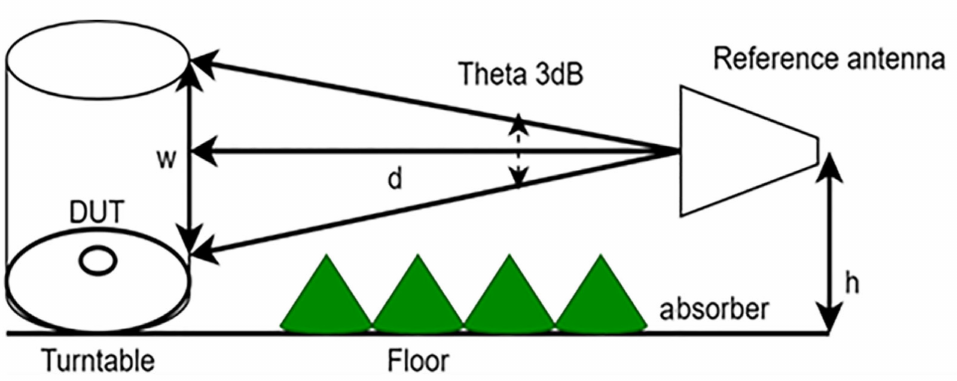
Figure 1. The EMC measurements chamber according to the CISPR